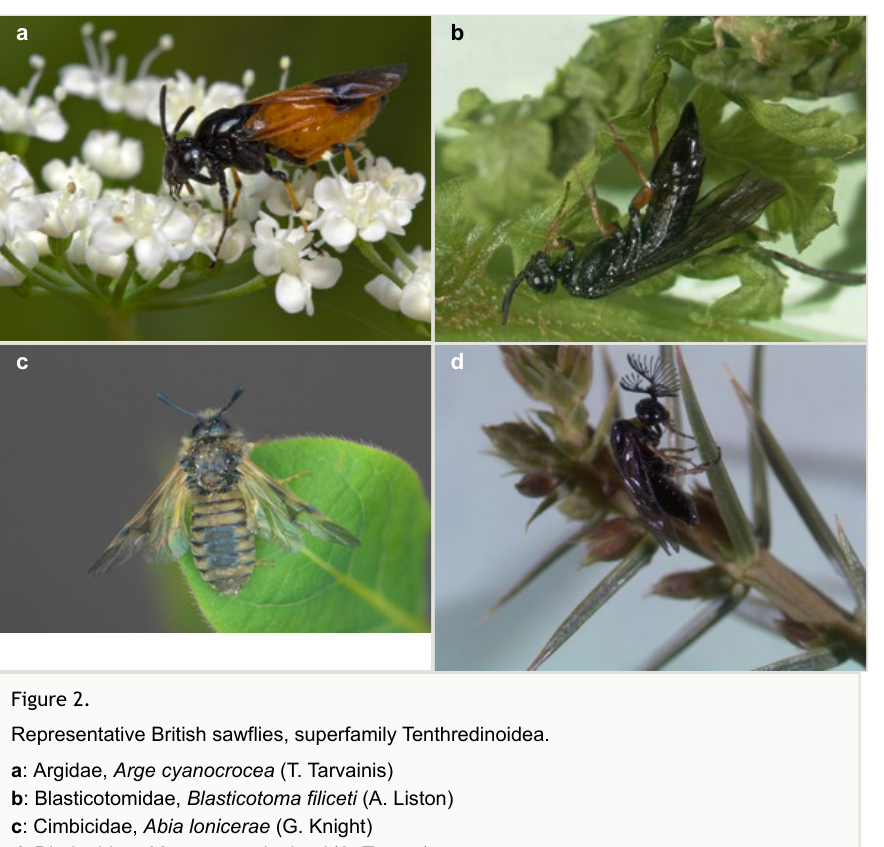
Figure 2. Representative British sawflies, superfamily Tenthredinoidea. a : Argidae, Arge cyanocrocea (T. Tarvainis) b : Blasticotomidae, Blasticotoma filiceti (A. Liston) c : Cimbicidae, Abia lonicerae (G. Knight) d : Diprionidae, Monoctenus juniperi (A.